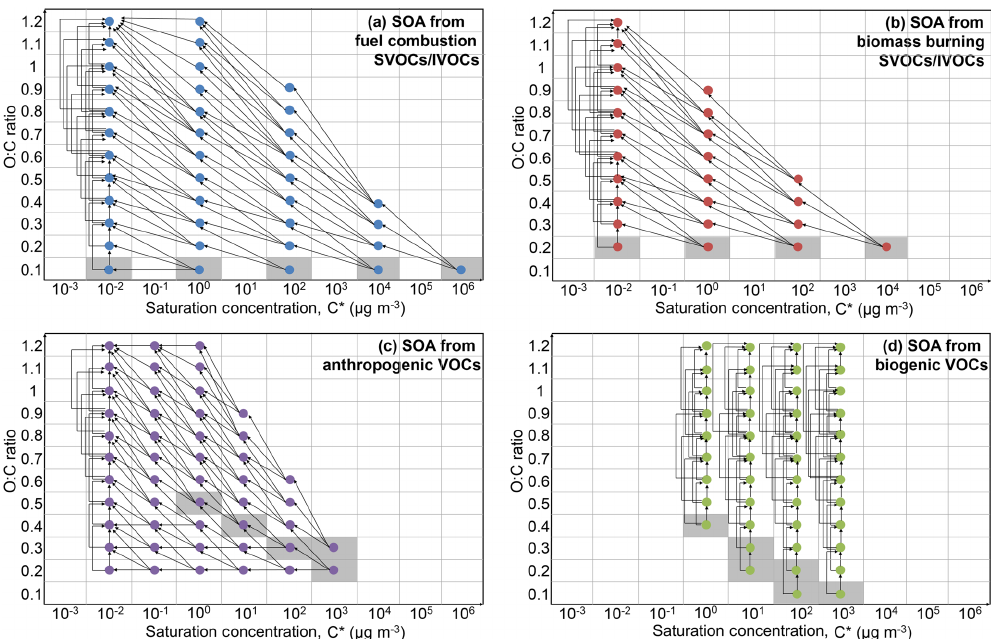
Figure 1. The 2-D grid space in the ORACLE 2-D module with saturation concentration (in µgm − 3 ) on the x axis and the O:C ratio on the y axis. For each cell an organic surrogate compound is defined with a specific carbon number calculated as a function of effective saturation concentration and O:C ratio. The formation and evolution of SOA from (a) fuel combustion SVOCs and IVOCs, (b) biomass burning SVOCs and IVOCs, (c) anthropogenic VOCs and, (d) biogenic VOCs are shown. The arrows correspond to aging reactions and the grey grids to the initial chemical state of the species prior to